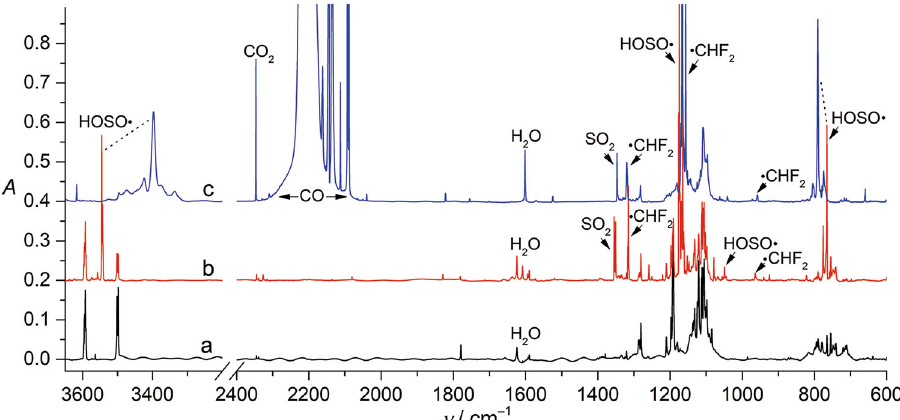
Fig. 2 | Infrared (IR) spectrum of CHF 2 S(O)OH and HOSO • in matrixes. a IR spectrum of CHF 2 S(O)OH in Ar-matrix at 10K. b IR spectrum for the high ‑ vacuum fl ash